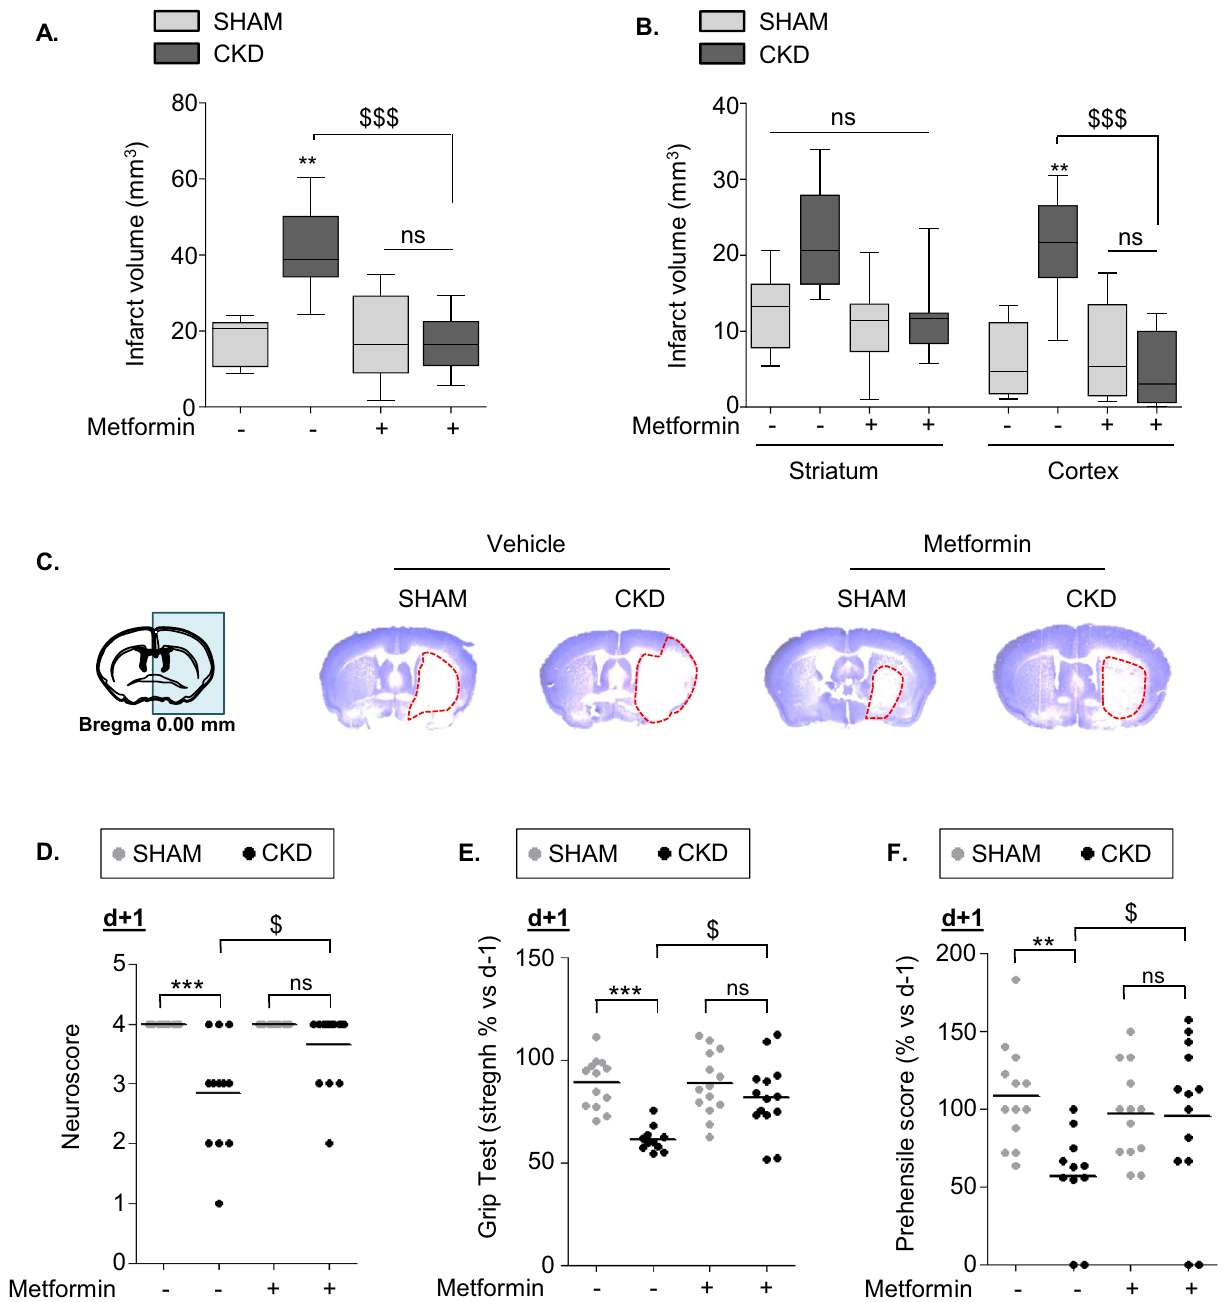
Figure 1. Metformin pre-conditioning reduces infarct volume and neurological deficits after tMCAO in CKD mice. ( A – C ) Analysis of total ( A ), as well as cortical and striatal ( B ), infarct volumes in SHAM and CKD animals exposed, or not, to metformin. Representative images of cresyl-violet staining are presented in ( C ). Results are expressed as the median, interquartile, and min–max. n = 7 SHAM-veh, n = 14 CKD-veh, n = 8 SHAM-met, n = 12 CKD-met. Statistical analysis was performed using a non-parametric Kruskall–Wallis test followed by Dunn’s multiple comparison post-hoc test. **p < 0.01, CKD-vehicle vs. SHAM-vehicle mice (non-parametric Mann–Whitney U test). $$$ p < 0.001, CKD-metformin vs. CKD-vehicle mice (non-parametric Mann–Whitney U test). ( D – F ) Neurobehavioral evaluation performed 24 h after tMCAO. n = 13 SHAM- veh, n = 11–12 CKD-veh, n = 14 SHAM-met, n = 14 CKD-met. Statistical analysis was performed using a non-parametric Kruskall–Wallis test followed by Dunn’s multiple comparison post-hoc test. **p < 0.01 and ***p < 0.001, CKD-vehicle vs. SHAM-vehicle mice. $ p < 0.05, CKD-metformin vs. CKD-vehicle